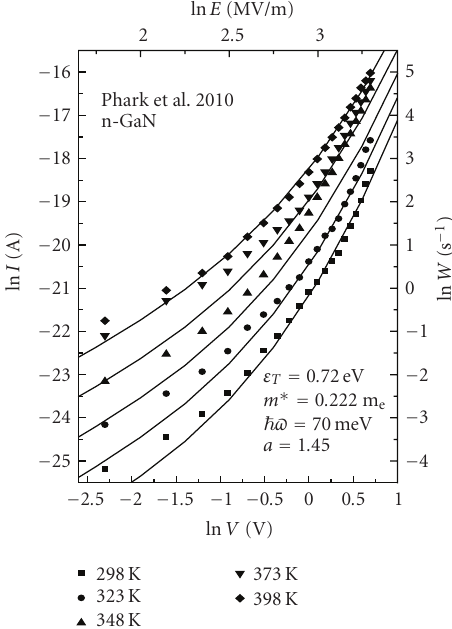
Figure 5: Reverse bias I - V characteristics of the Pt Schottky contacts to a -plane n-GaN extracted from Figure 2 [26] (symbols) fitted to theory (solid curves) Parameters: ε T = 0 . 72 eV, m ∗ = 0.222 m e , (cid:2) (cid:5) = 70meV, a = 1 . 45. Assessed state density N S = 1 . 4. 10 13 cm − 2